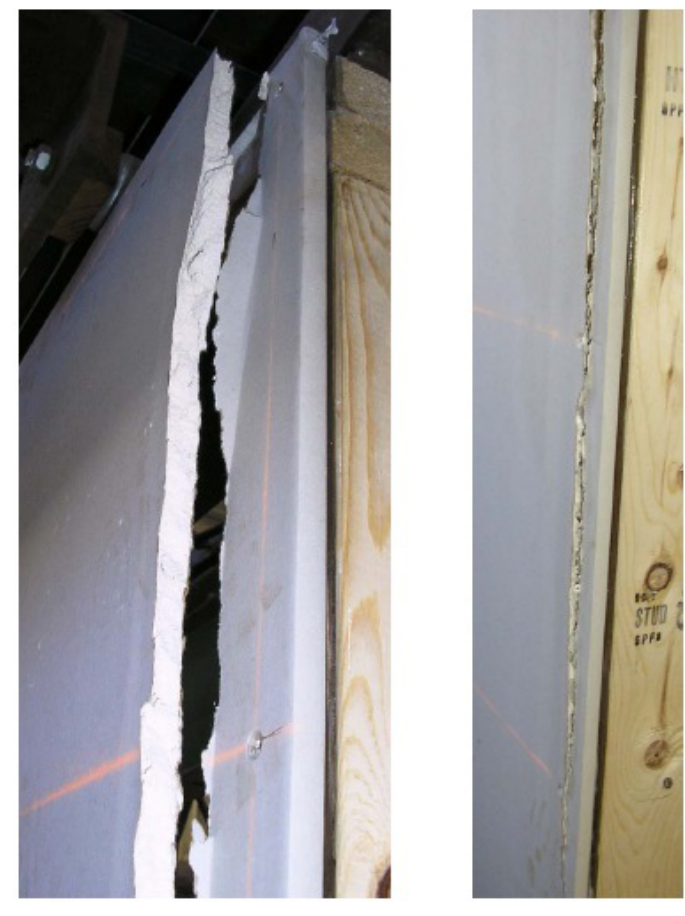
Figure 22. Crack propagation along the edge of VEwall